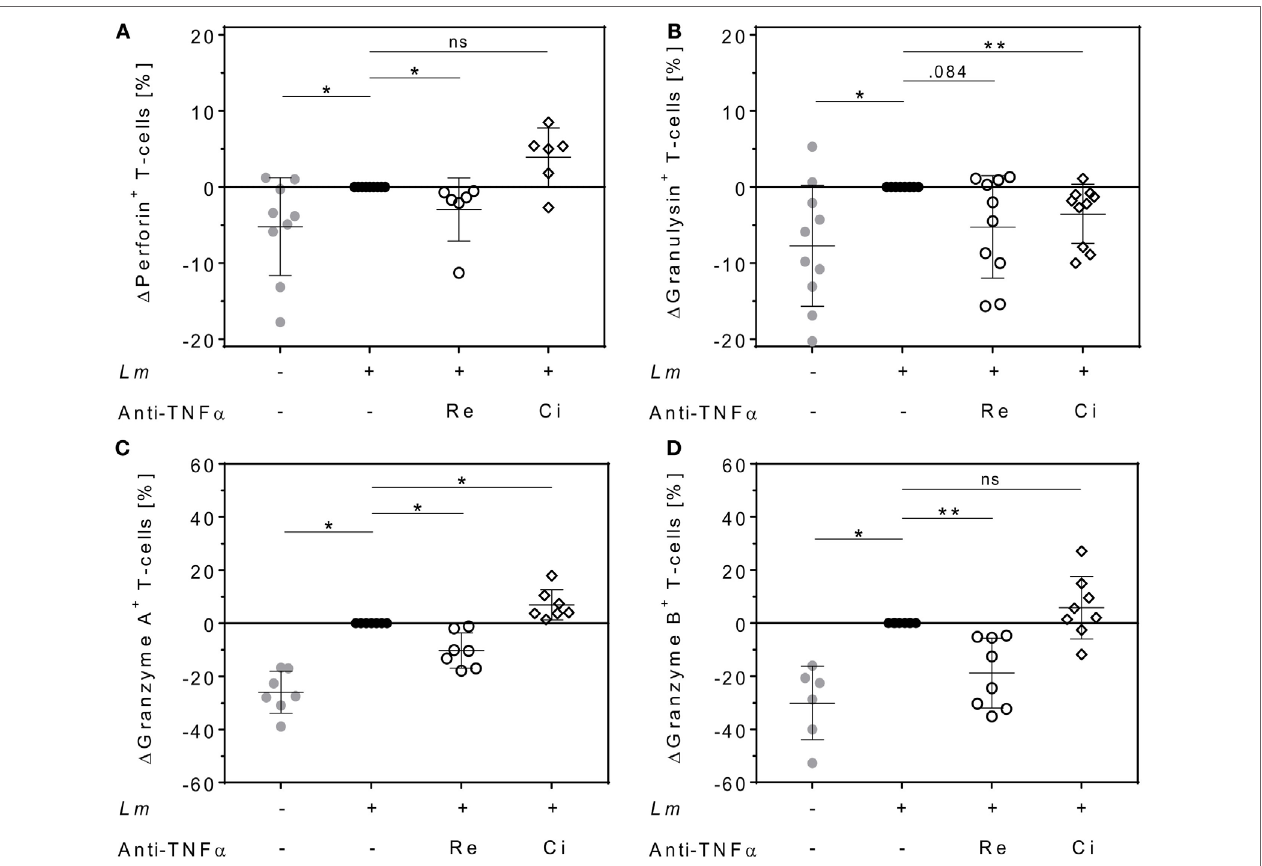
FigUre 5 | Intracellular expression of cytolytic proteins in proliferating CD4 + T-cells differs after soluble TNF α (sTNF α ) neutralization by Remicade ® or Cimzia ® . Non-infected ( ● ) or Leishmania major ( Lm )-infected human monocyte-derived macrophages (hMDMs) ( ● ) were co-incubated with CFSE-labeled autologous peripheral blood lymphocytes and sTNF α was neutralized by Remicade ® (Re ○ ) or Cimzia ® (Ci ◊ ). Proliferating CD4 + T-cells expressing perforin (a) , granulysin (B) , granzyme A (c) , or granzyme B (D) were detected using anti-CD3 and anti-CD4 Ab co-staining in intracellular flow cytometry 7 days post-infection. Values are illustrated as differences to the untreated control of the same donor. Data are presented as mean ± SD ( n ≥ 6) and were obtained in at least three independent experiments. To analyze statistical significance, the Wilcoxon signed-rank test was performed. * P < 0.05; ** P <